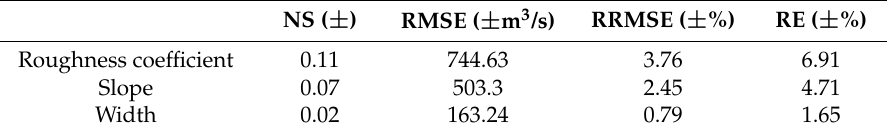
Table 4. Estimated resultant errors associated with the roughness coefficient, slope and width parameters using Equation (4) at virtual station 1.